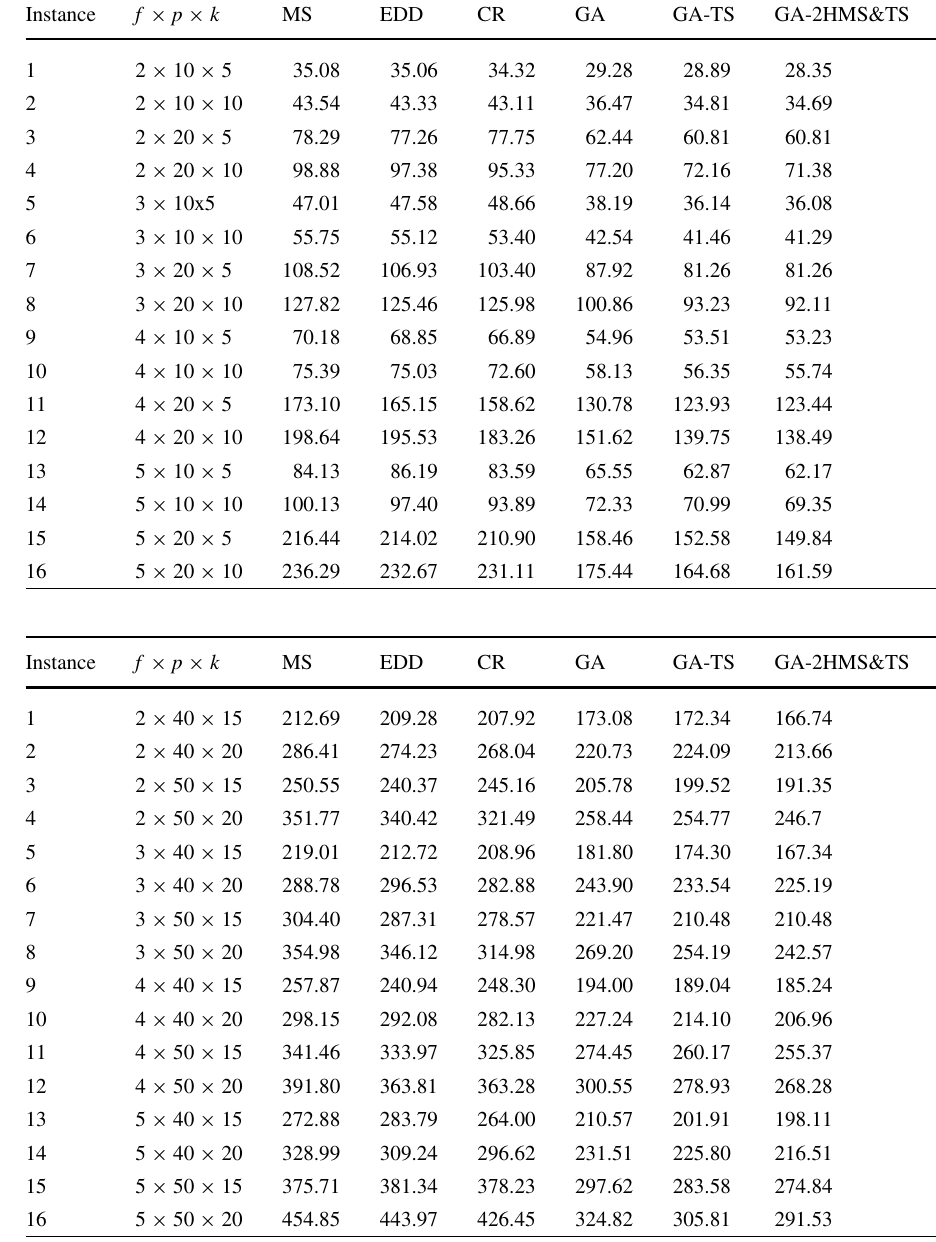
Table 5 Results with different algorithms for small sized examples